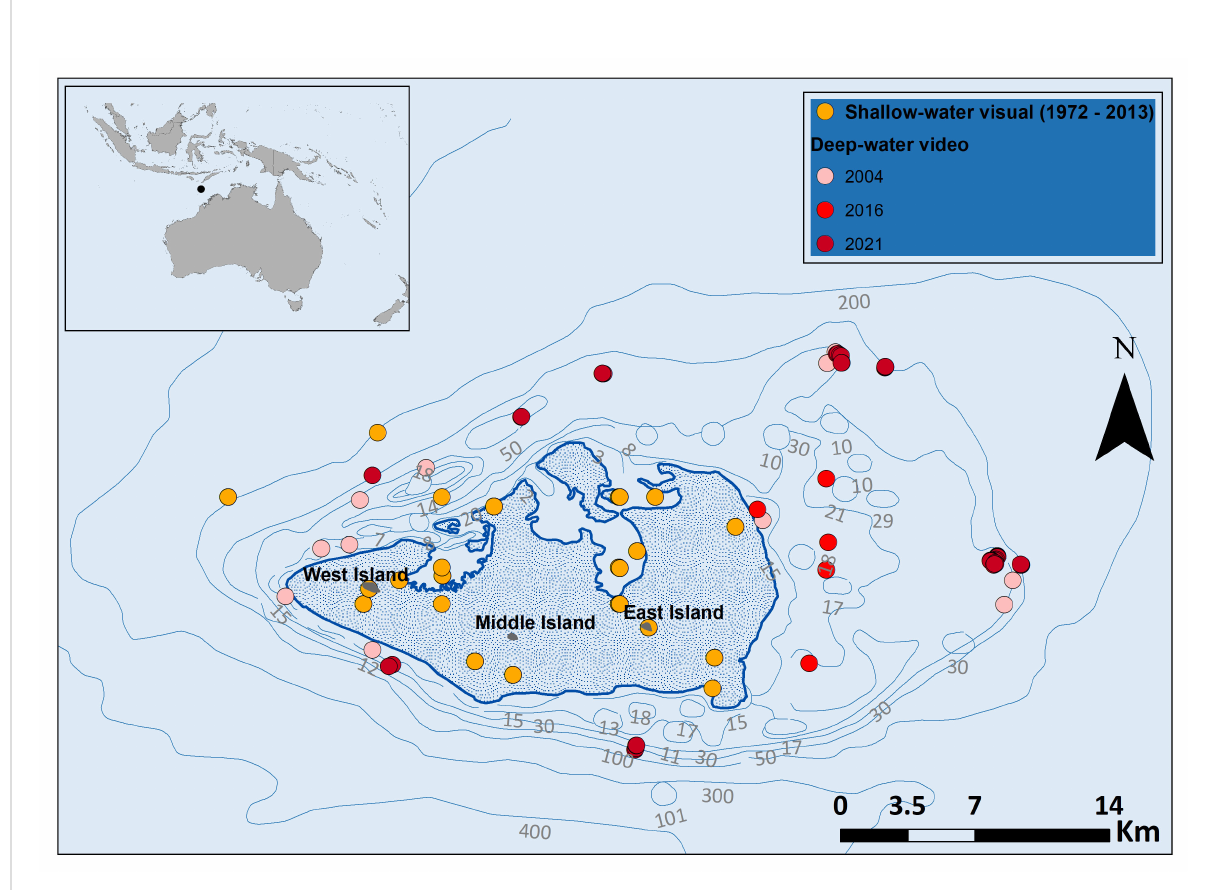
FIGURE 1 Sea snake sightings in and around Ashmore Reef. The deep-water video surveys in 2004 and 2016 were done using BRUVS, whereas the 2021 survey used an ROV. Shallow-water visual survey data downloaded from Atlas of Living Australia; occurrence download at https://doi.ala.org.au/ doi/8b85f7f1-8ba7-40fe-a69c-6c48f5f45962;jsessionid=4A9BACF61A47968B6A7B1E2738C05DBF, Accessed September 2021. Thick blue line denotes the reef edge and shaded area includes shallow coral Reef